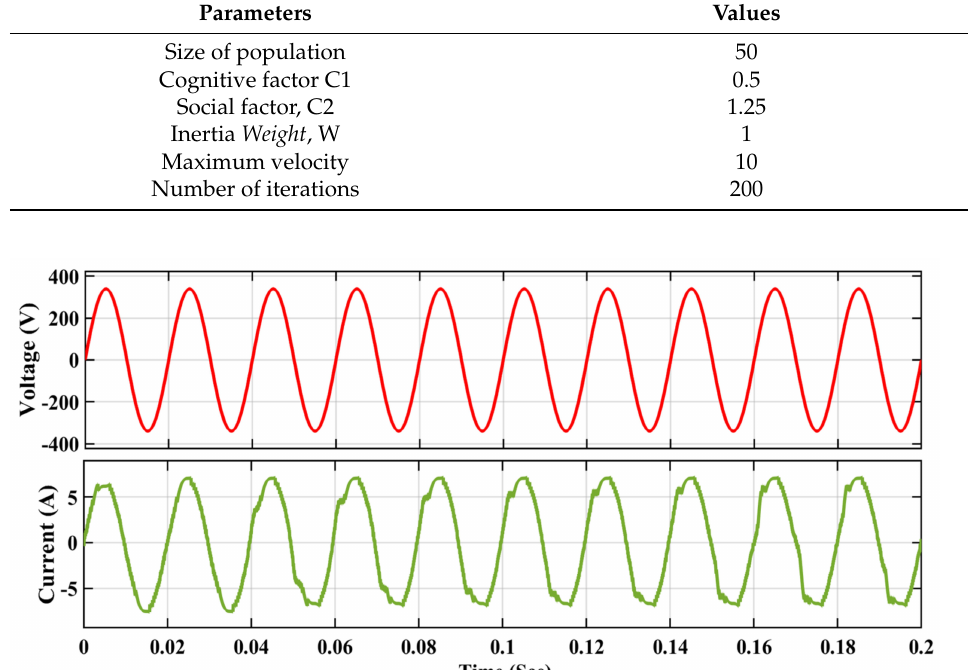
Figure 15. Grid voltage and grid current waveforms with PSO-PI controller.